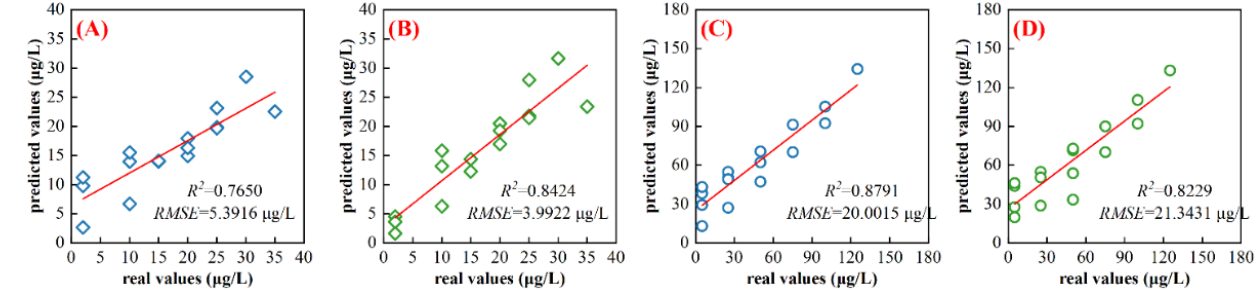
Figure 7. SVR model results for Cd 2+ ( A , B ) and Pb 2+ ( C , D ) concentration detection in the validation dataset. (Diamond scatters represent Cd 2+ concentrations, circular scatters represent Pb 2+ concentra- tions, blue scatters represent the model input as I manu , green scatters represent the model input as I algo ).